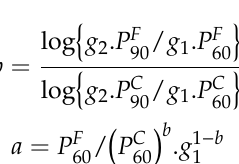
Figure 6. Flowchart of the transformation of the observation time series, or application of the coefficients (adapted from [42]).